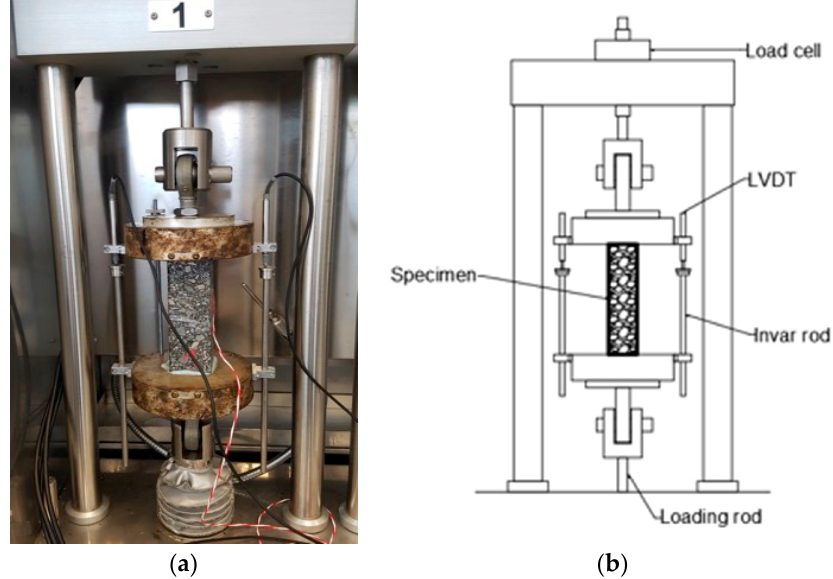
Figure 3. Tensile Creep Test (TCT) and Uniaxial Tension Stress Test (UTST) setup: ( a ) photograph of the specimens during the test, ( b ) schematic